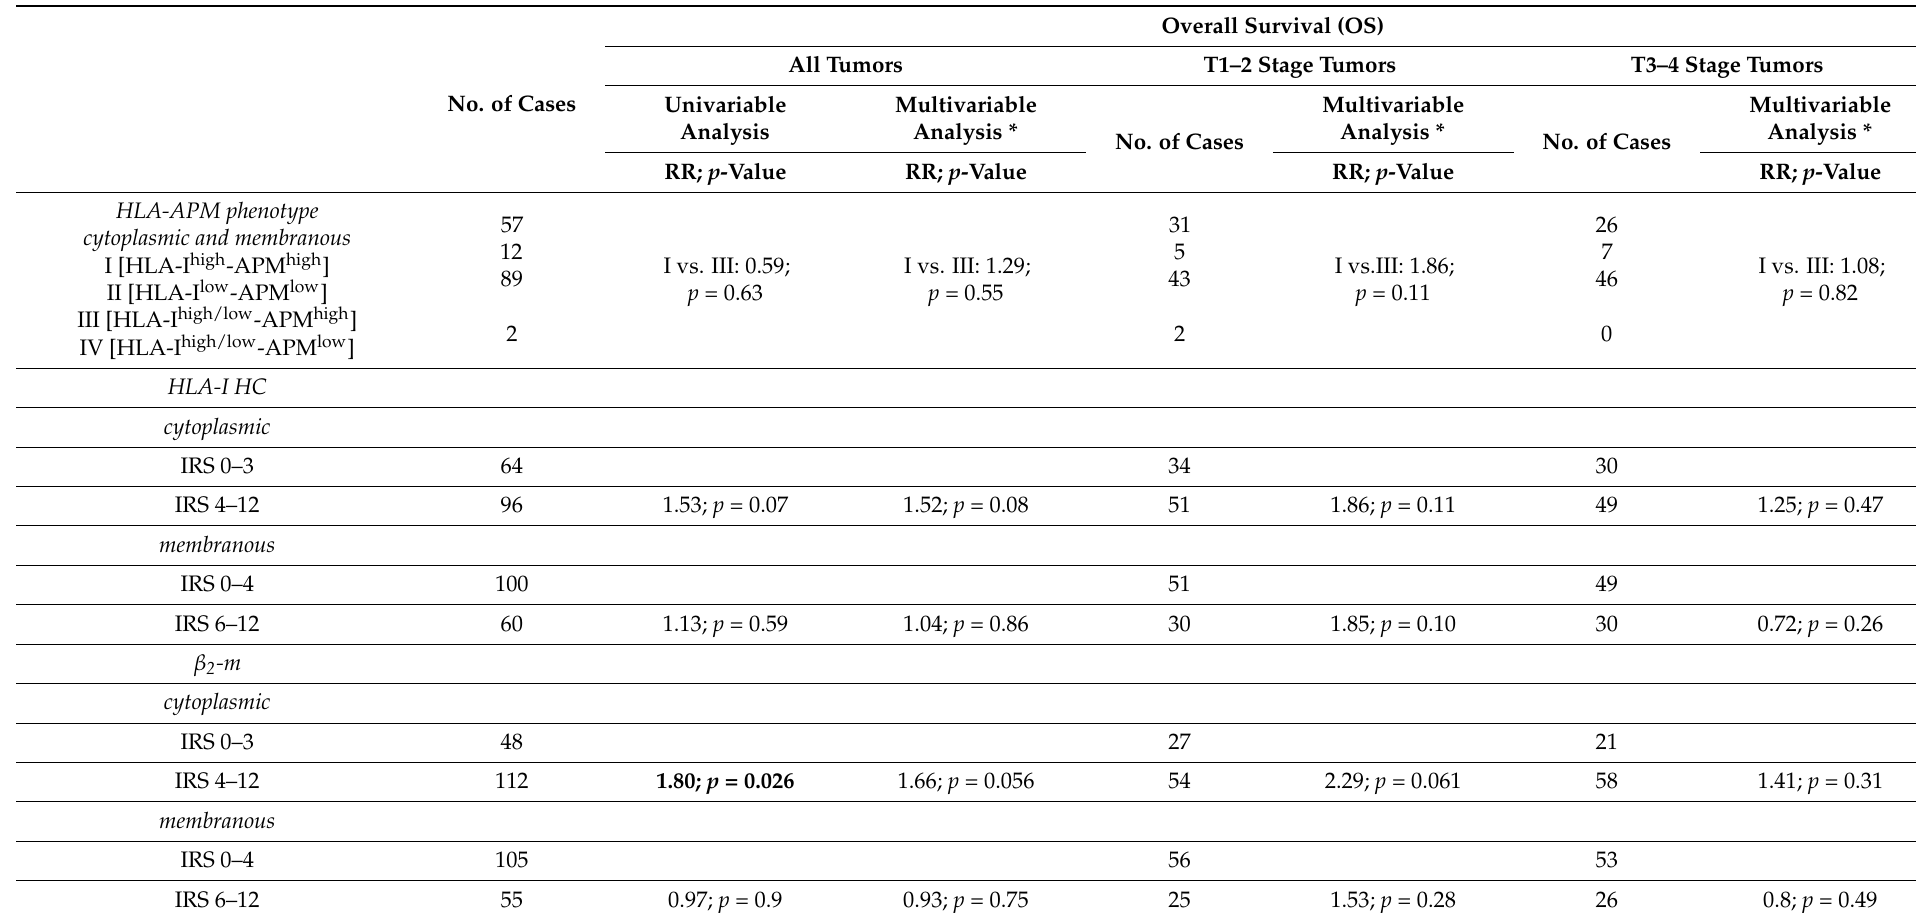
Table 7. Expression of HLA-I/APM components and correlation with T1/2 and T3/4 stage as well as overall